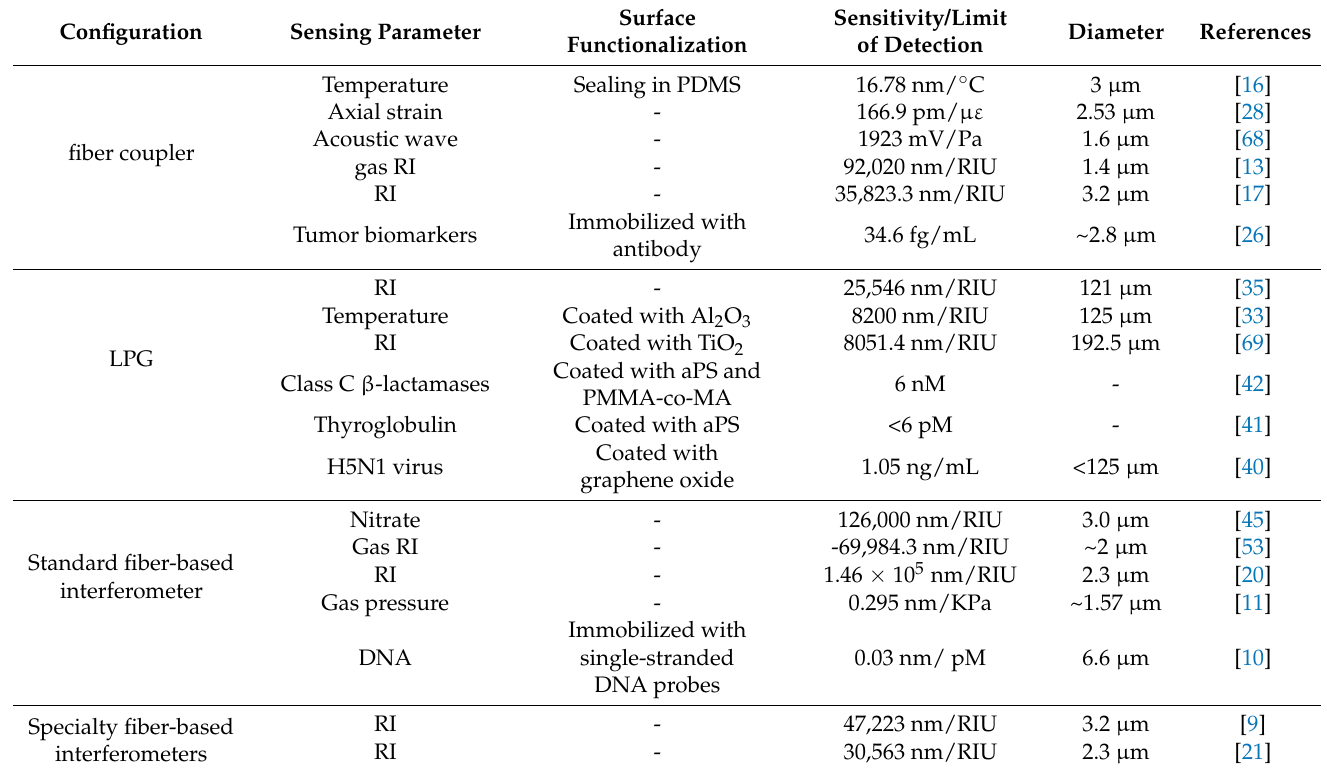
Table 1. Fiber sensor performance based on the theory of the dispersion turning point.